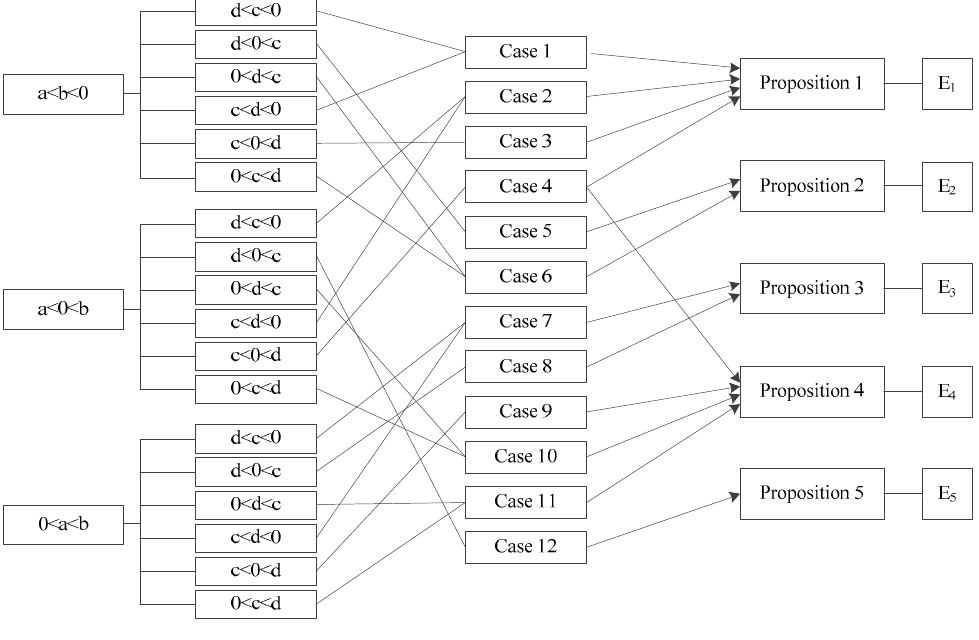
Figure 3. Diagram of classification.